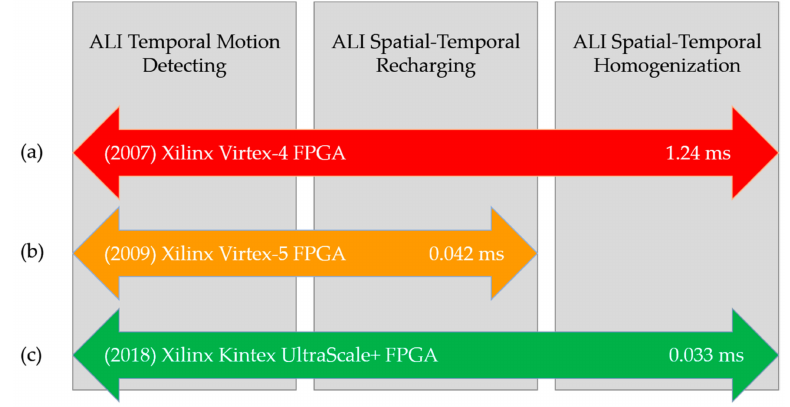
Figure 5. Implementations included in the comparative study. ( a ) ALI implementation with Xilinx Virtex-4 [9]. ( b ) AC implementation with Xilinx Virtex-5 [10]. ( c ) Current ALI implementation with Xilinx Kintex